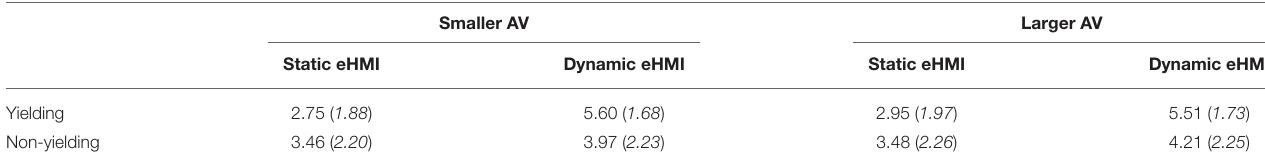
TABLE 5 | Pedestrians’ perceived support of eHMI regarding the vehicle size (smaller AV, larger AV), vehicle kinematics (yielding, non-yielding), and eHMI status (static eHMI, dynamic eHMI).